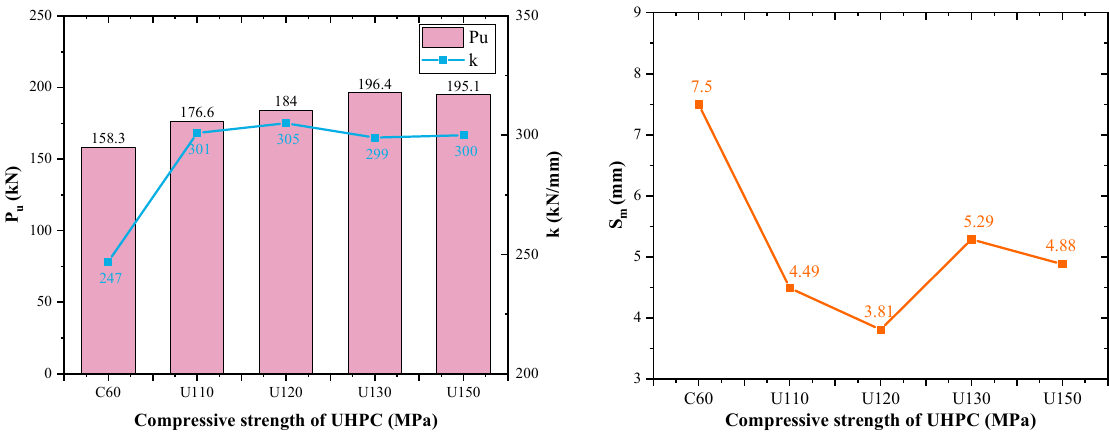
Figure 27. Influence of compressive strength of connection concrete on ultimate strength and shear stiffness.